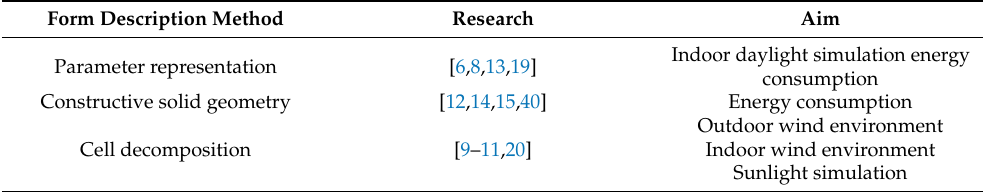
Table 2. Literature related to different forms of description methods in field of machine